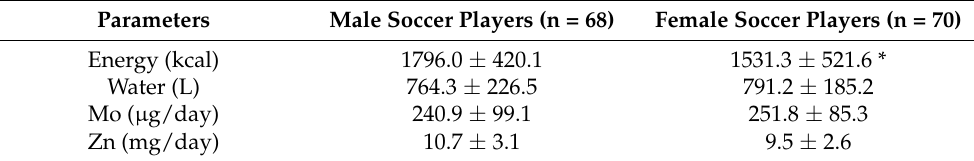
Table 3. Energy, water, Mo and Zn intake of participants.